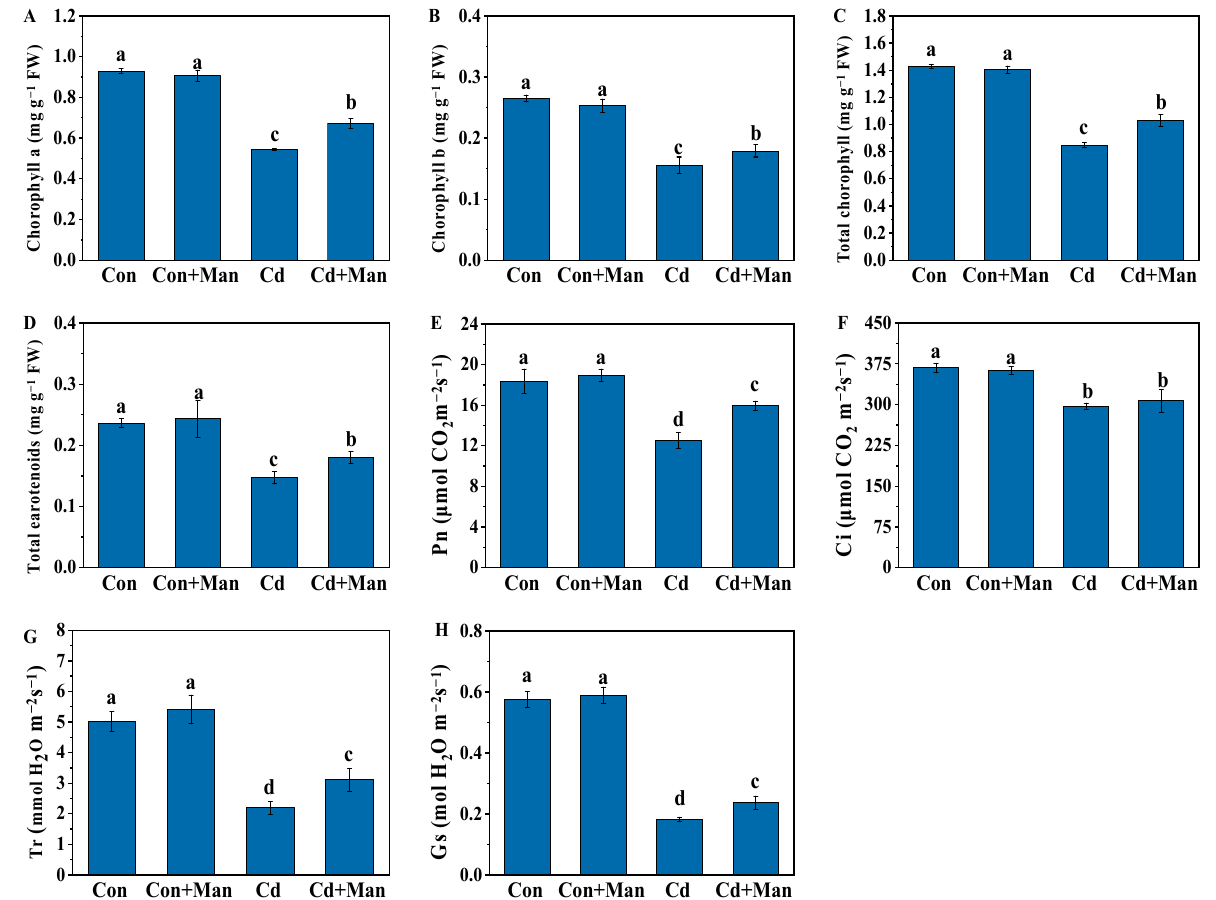
Figure 3. Effects of MAN on the chlorophyll a content ( A ); chlorophyll b content ( B ); total chlorophyll content ( C ); carotenoids content ( D ); net photosynthetic rate ( E ); intercellular CO 2 concentration ( F ); transpiration rate ( G ); and stomatal conductance ( H ) in wheat leaves under Cd stress. One-week-old wheat seedlings under 20 µ M CdCl 2 were sprayed with 0 or 160 µ M MAN for two weeks. Data are the means ± SD and different letters above columns indicate a significant difference at p ≤ 0.05 among treatments.